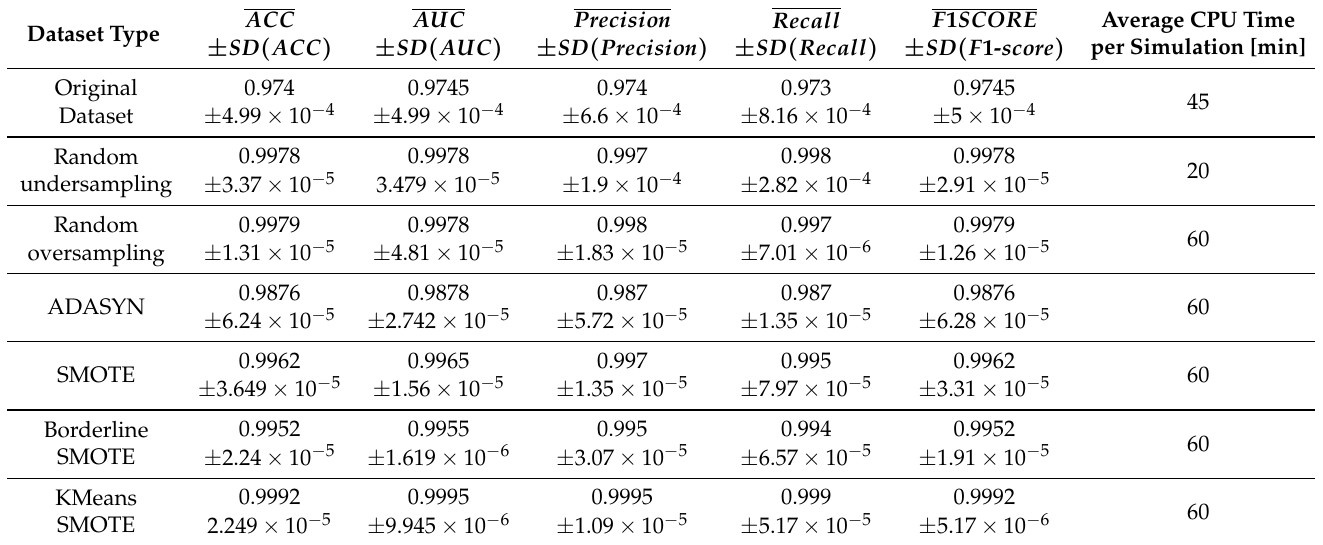
Table 9. The mean and standard deviation values of ACC , AUC , Precision , Recall , and F 1- score obtained in case of GPSC with random hyperparameter search on train/test split in ratio